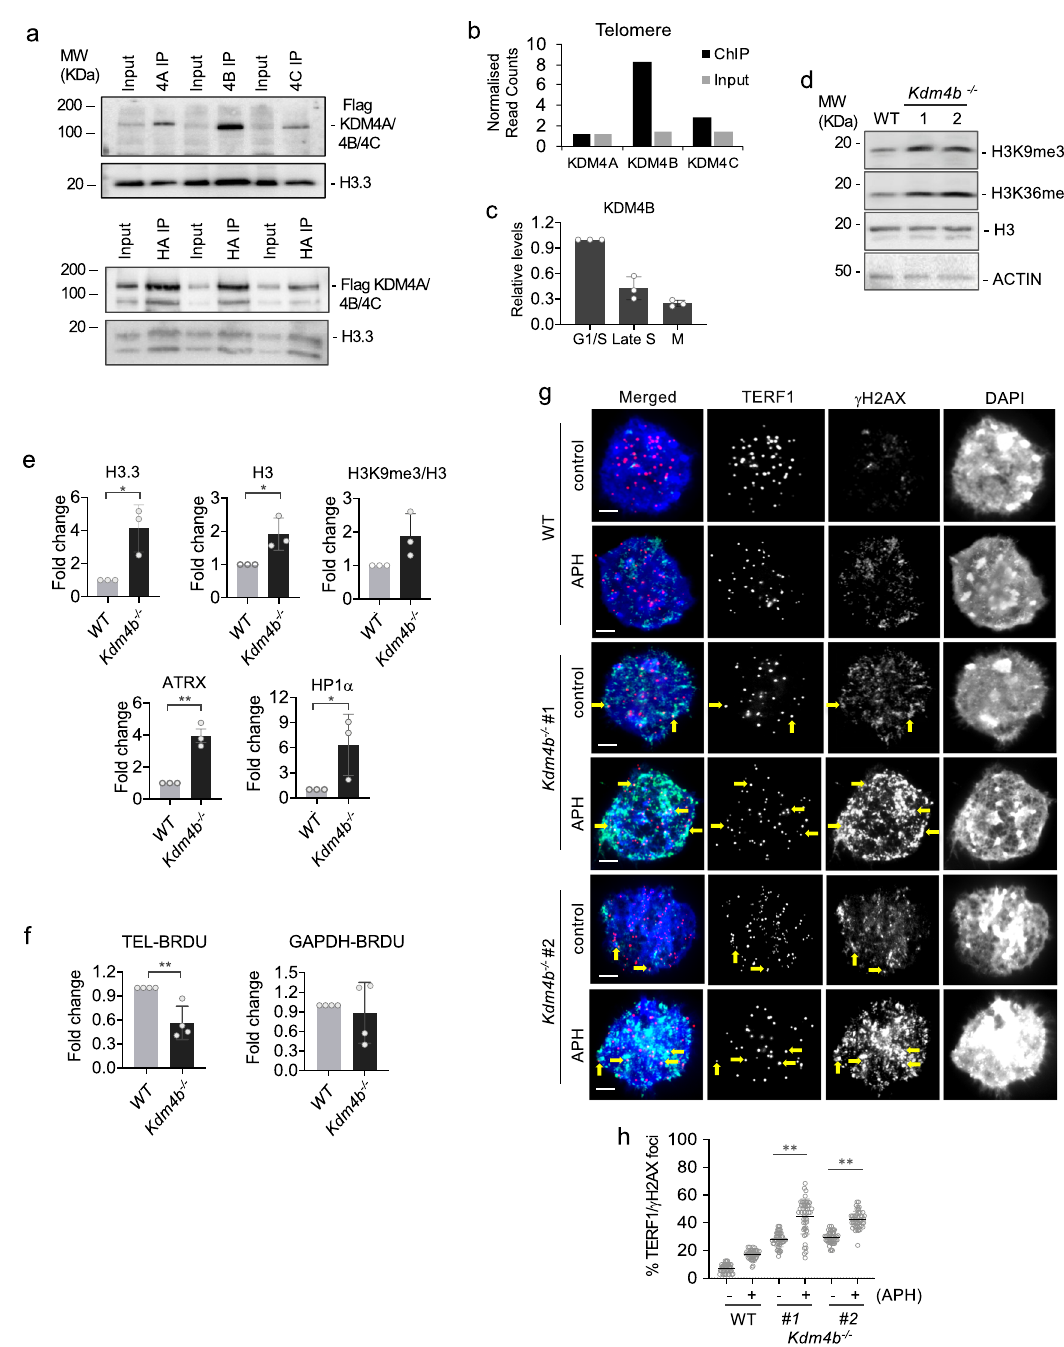
Fig. 2 KDM4B − / − mouse ES cells show replication stress. a Protein immunoprecipitation with an anti-Flag antibody in ES cells expressing HA-H3.3 and either Flag-tagged KDM4A, KDM4B or KDM4C, followed by western blot analysis with an anti-HA antibody. b ChIP-sequencing analysis of KDM4 -A 34 , -B 33 and -C 33 with input sequencing. Data shows reads which aligned to telomeres, normalised for total read counts showing KDM4B binding to telomeres. c ChIP-qPCR analysis of KDM4B at telomeres in cell cycle-synchronised cells ( n = 3 independent experiments). d Western blot analyses of WT and KDM4B cells using antibodies against H3K9me3, H3K36me3, H3 and ACTIN. e ChIP-qPCR analyses of H3.3, total H3, H3K9me3, ATRX, HP1 α . Level of H3K9me3 was normalised to total H3 levels (H3K9me3/H3) ( n = 3 independent experiments). f ChIP-qPCR analyses of BrdU incorporation at telomeres and Gapdh promoter in WT and Kdm4b − / − cells ( n = 4 independent experiments). g, h Immuno fl uorescence analyses of TERF1 (red; diluted at 1/500) and γ H2AX (green; diluted at 1/1500) in WT and Kdm4b − / − cells with and without 1 mM APH treatment for 5 h. Arrows indicate presence of DNA damage ( γ H2AX) at telomeres (TERF1). Scale bars: 5 μ m. Percentages of co-localised TERF1 and γ H2AX foci in two independent Kdm4b − / − cell lines ( Kdm4b − / − #1 and #2) are shown in h . For each cell line, >1500 telomeric or TERF1 foci were counted ( n = 4 independent experiments). Percentage of co-localised TERF1/ γ H2AX foci are determined as percentages of telomeric foci that co-stained with γ H2AX over the total number of telomeric foci counted. c , e , f , h Data are presented as mean values ± SD. *indicates p < 0.05 and **indicates p < 0.005, Student ’ s t -test with two-tailed distribution. a , d , g Representative images and blots from at least n = 3 independent experiments. Source data are provided with this